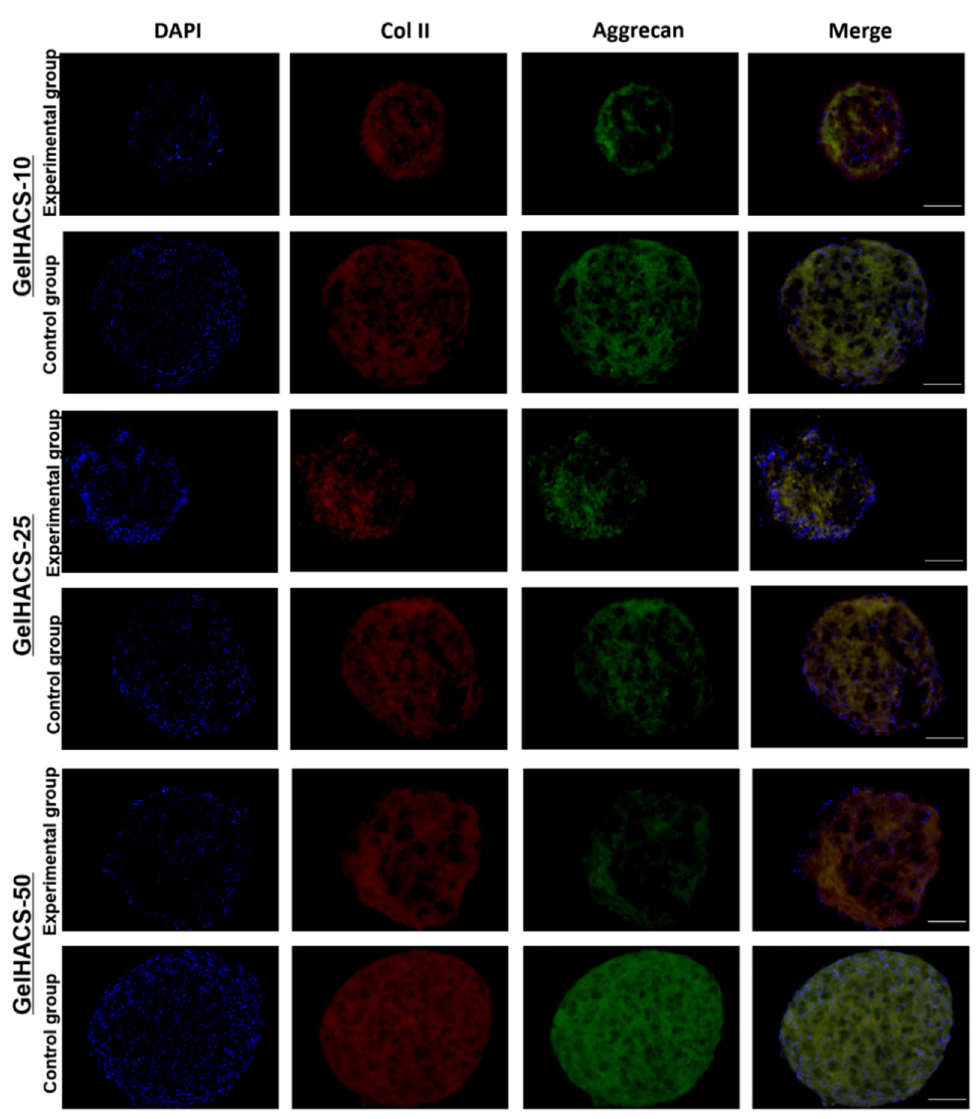
Figure 8. Expression of collagen II and aggrecan in ADMSC spheroids cultured in different cryogels. Red represents collagen II, green aggrecan and blue cell nuclei (blue) are stained by DAPI. Scale bar = 100 μ m.